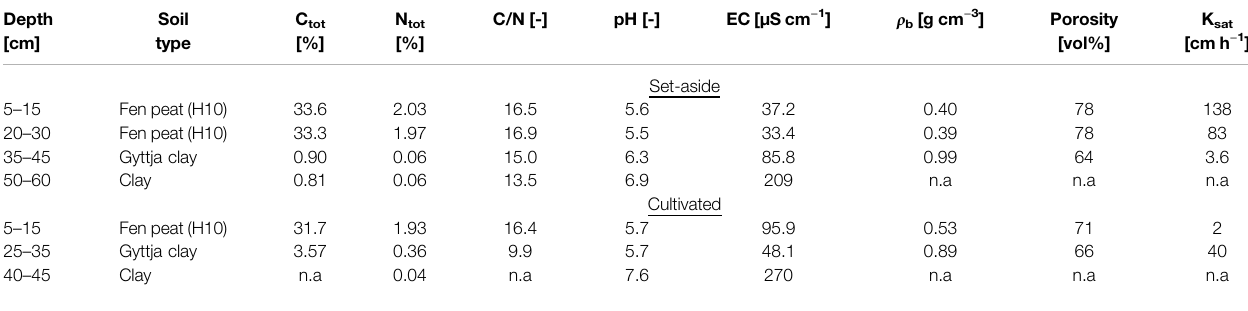
TABLE1| Soilpropertiesattheset-asideandcultivatedstudysites.Soilsamplingwasperformedonbaresoilattheset-asidesite,afterremovingthegrasssward.Allvalues aremeans(n (cid:1) 4).H10 (cid:1) humi fi cationdegree(vonPost,1922),C tot (cid:1) totalcarboncontent,N tot (cid:1) totalnitrogencontent,soilpHwasmeasured